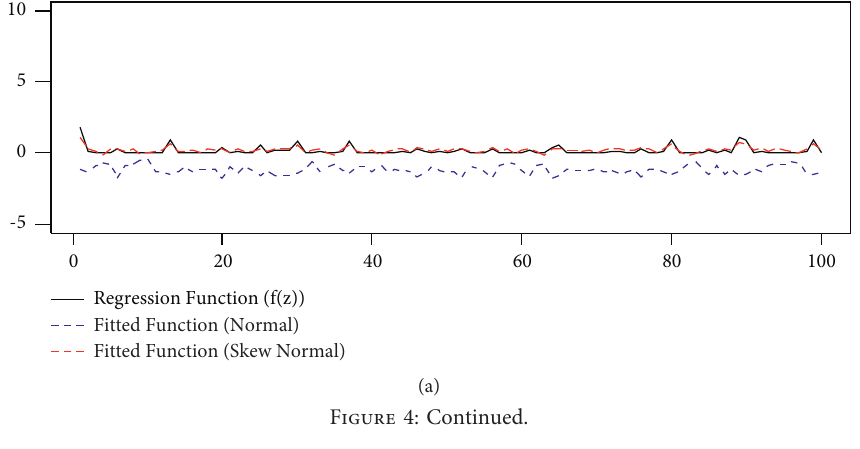
) from normal and SN models. (b) Exact and estimated values of data from normal and SN t ( x ) � 5 e − x 2 1